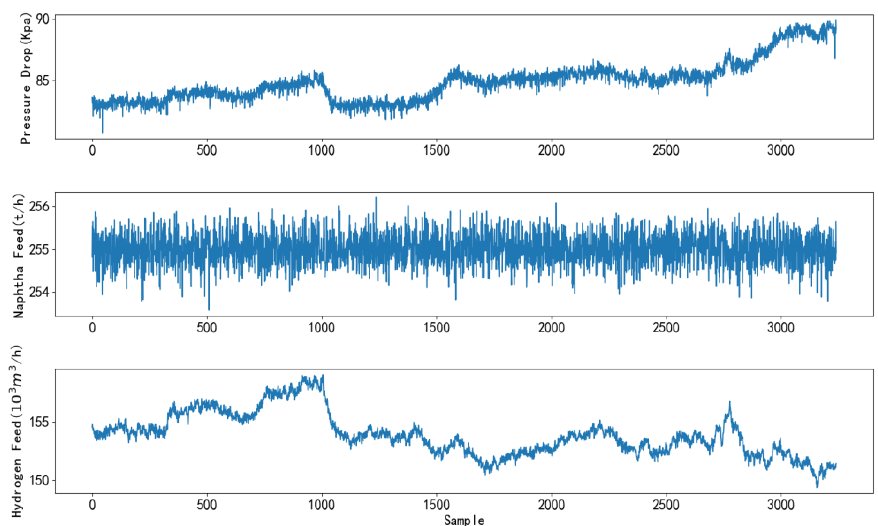
Figure 3. The variation in the feed volume and pressure drops.